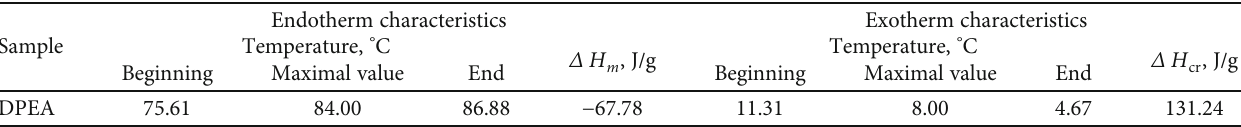
Figure 3: DSC thermogram of a plasticizer of DPEA. Table 3: DSC analysis of decyl phenoxyethyl adipate plasticizer.